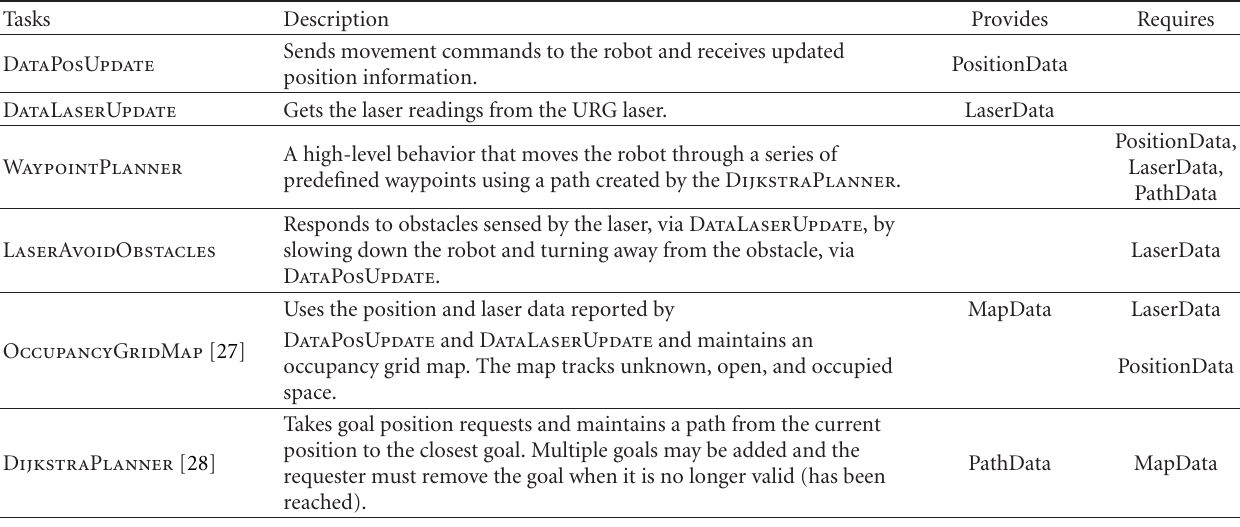
Table 1: Task threads used in the robot architecture.